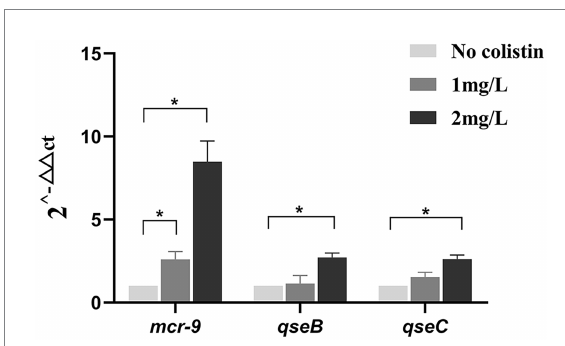
FIGURE 5 Expression of genes in clinical isolate CRECC414 with and without colistin exposure. The genes are the plasmid-located mcr-9 and the chromosome-located qseB and qseC . Fold changes in mRNA levels were determined by RT-qPCR. The data have been normalized to values for reference rpoB gene. Three independent replicates were performed and the data shown represent the means. The asterisks indicate statistical significance at different levels by Student’s t -tests: * p ≤